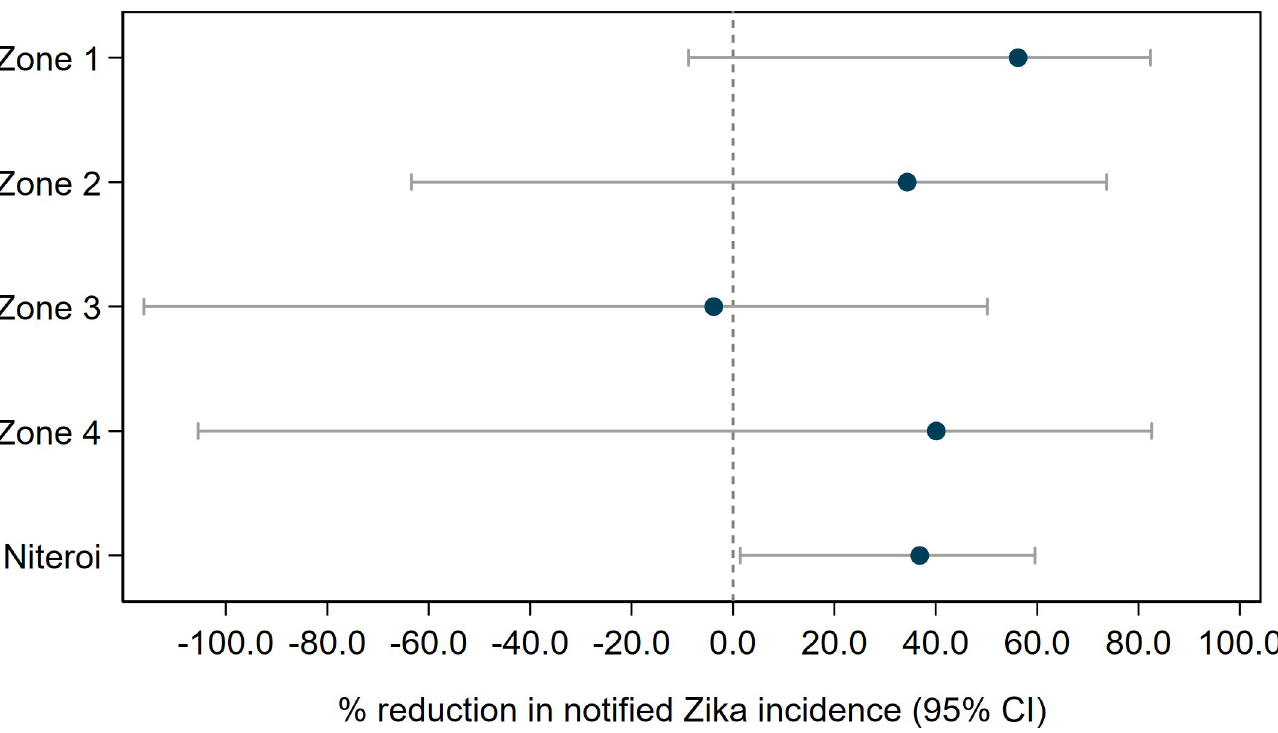
Fig 9. Estimated reduction in the incidence of Zika following Wolbachia deployments in Nitero´i, in each release zone individually and in the aggregate release area. Point estimates (circles) and 95% confidence intervals (horizontal bars) from controlled interrupted time series analysis of monthly Zika